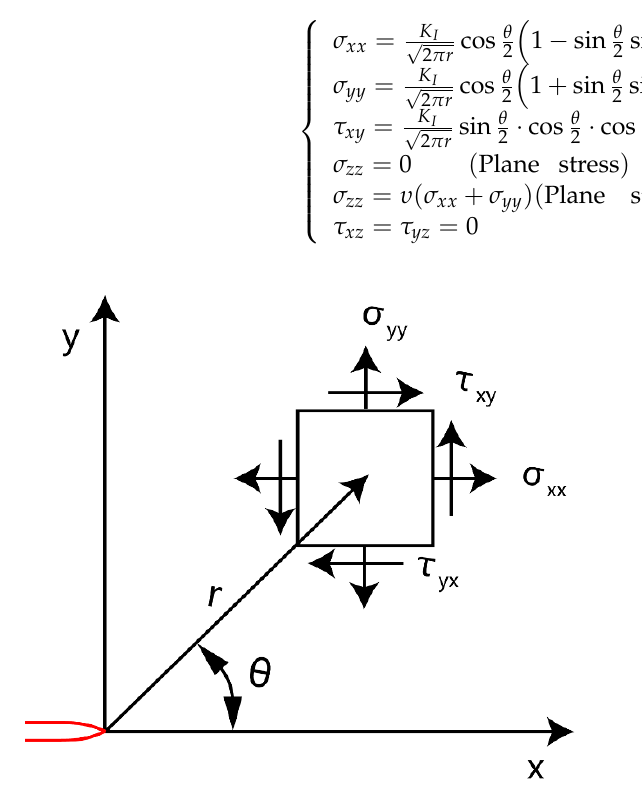
Figure 10. Three modes of loading relative to a crack: mode I (opening mode), mode II (shear or sliding mode), and mode III (tearing mode).